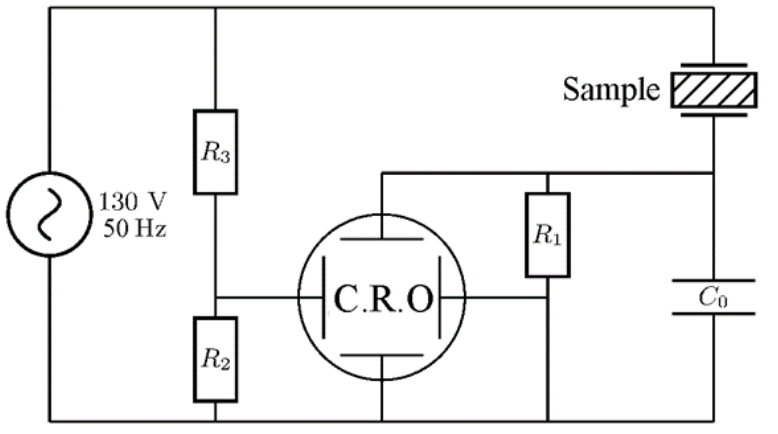
Figure 2. Sawyer–Tower circuit.